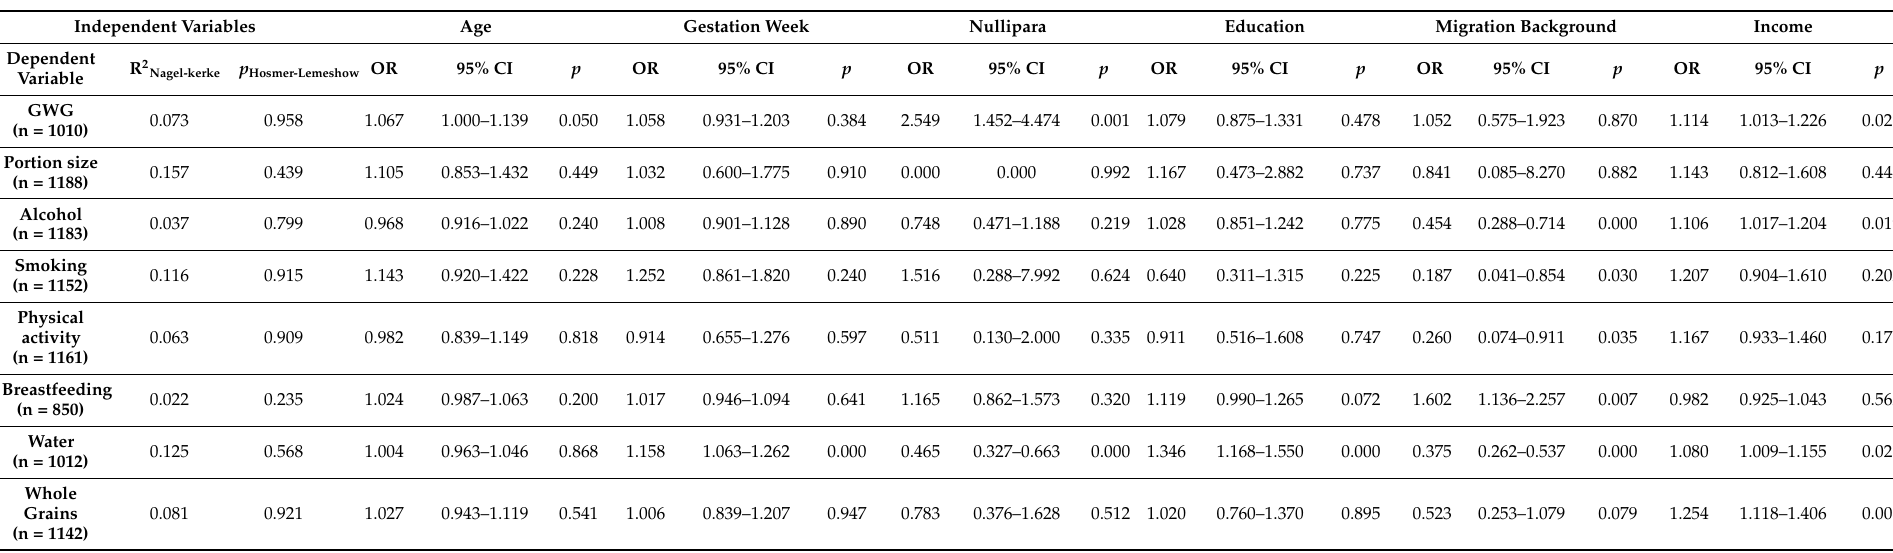
Table 6. Logistic regression with single